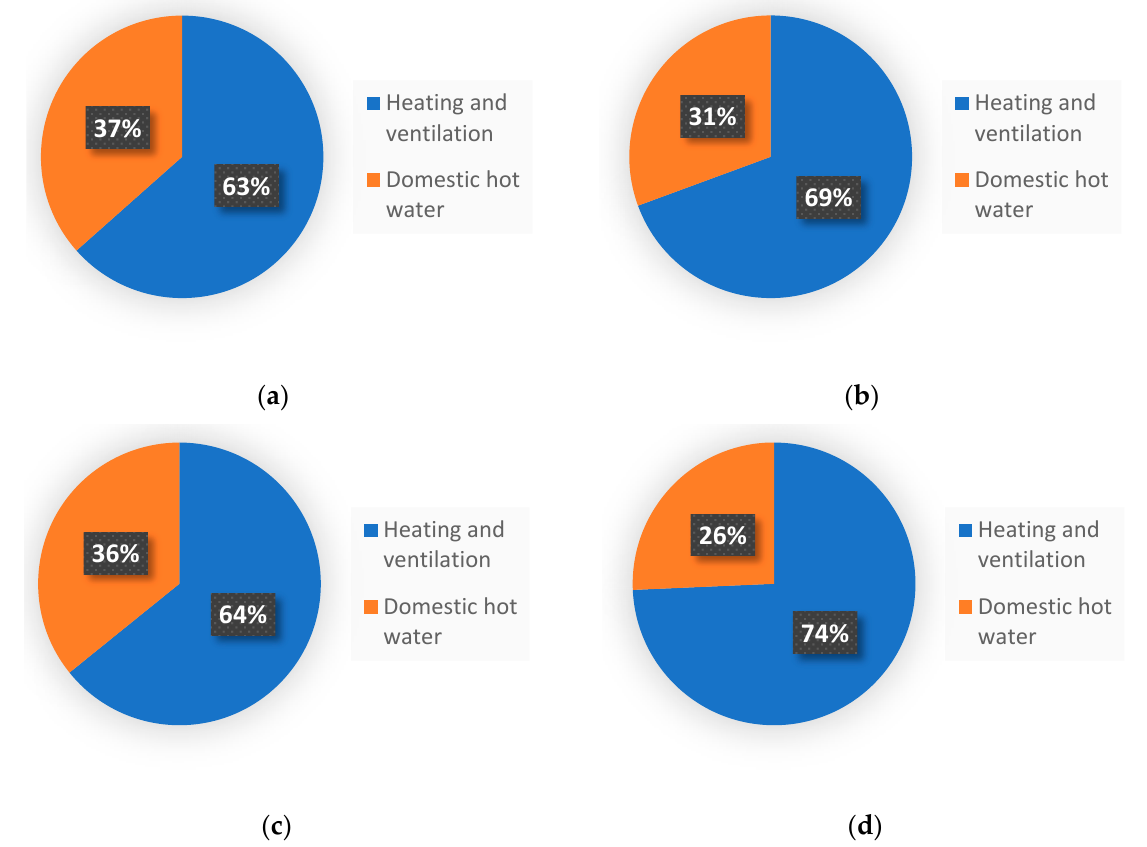
Figure 8. The share of primary energy demand used for DHW and heating/ventilation in older buildings with worse thermal